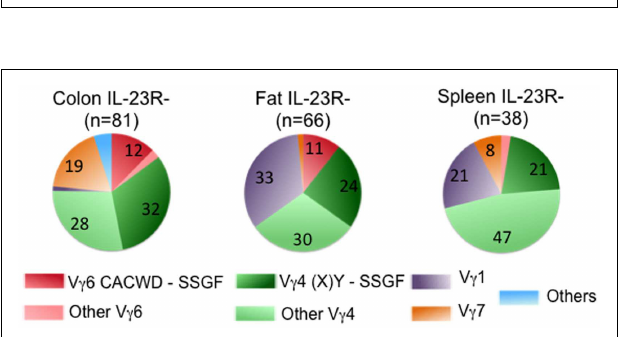
FIGURE 4 | Frequency ofV γ chain usage in IL-23R − cell population . Each pie chart represents each cell population. n , total number of analyzed sequences. Number with each section of the pie chart, the percentage of each group of sequences color-coded as indicated in Figure 2